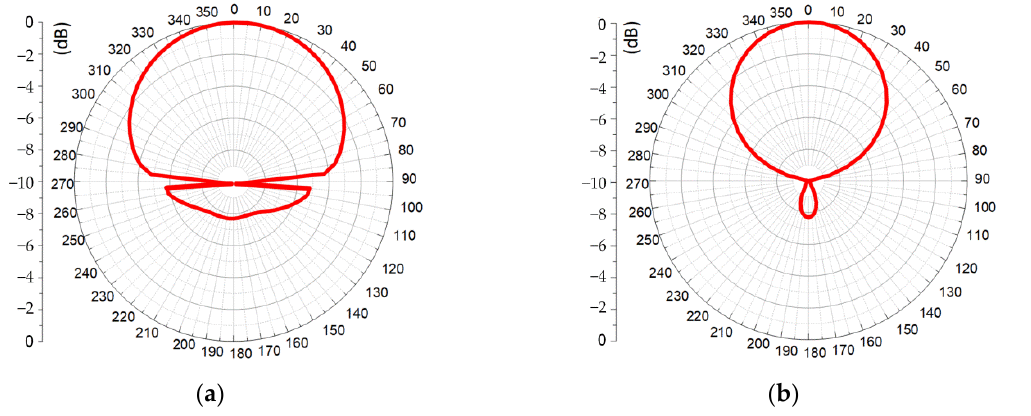
Figure 10. Directional diagrams of the RFID sensor: ( a ) horizontal plane H; ( b ) vertical plane V.